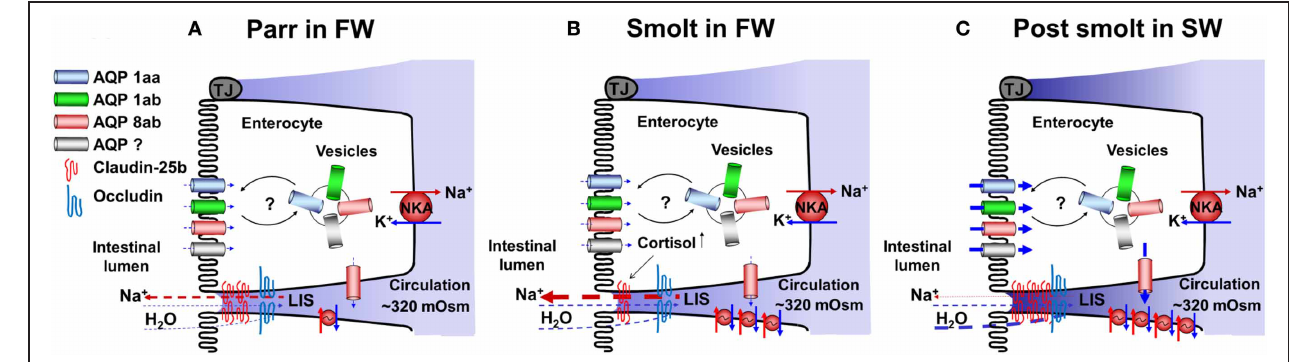
results of transcriptome analyses possible AQP positions in FW parr and smolts are suggested ( A and B ). Regarding tight junction proteins no protein expression has, as far as we know, been demonstrated. Thus the present model is based on transcriptome analyses of different claudin and occluding genes. NKA; Na + , K + -ATPase, LIS; lateral intercellular